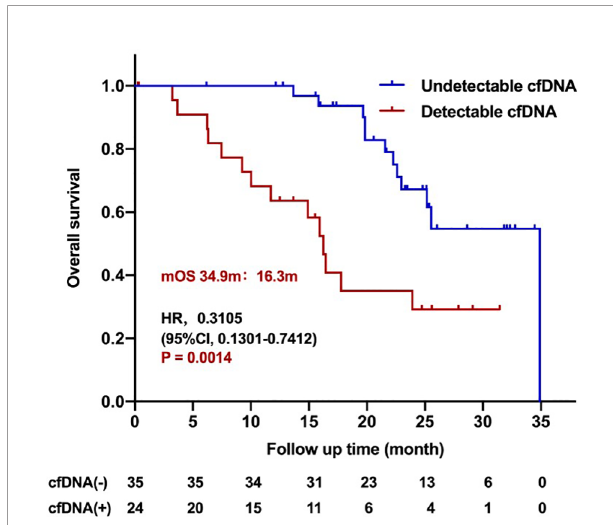
FIGURE 5 | Kaplan – Meier analysis of overall survival for patients treated with the third-generation EGFR TKIs according to dynamic cfDNA level during